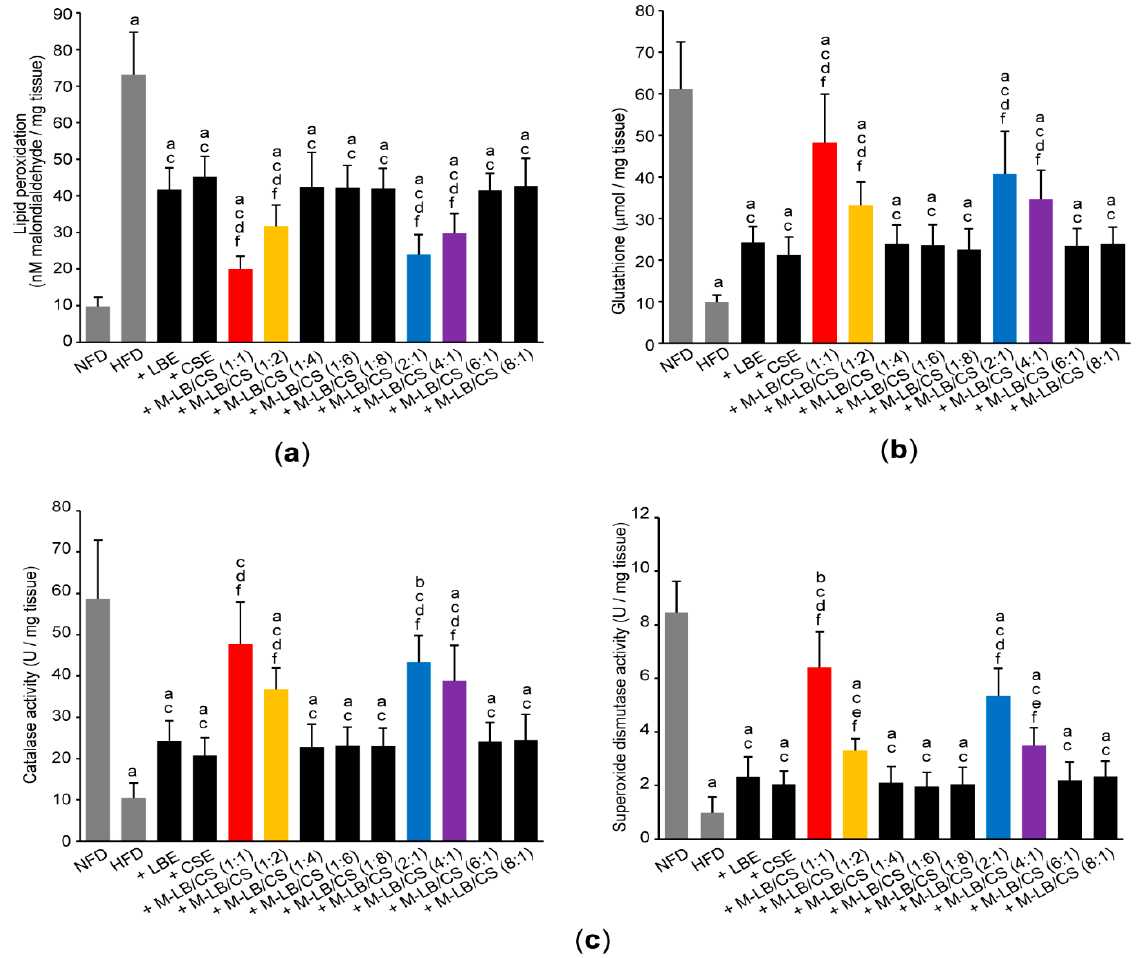
Figure 6. M-LB/CS scavenges lipid peroxidation. Malondialdehyde ( a ) and reduced glutathione ( b ) levels and specific activities of catalase and superoxide dismutase ( c ) were measured using liver homogenates. a p < 0.01, b p < 0.05, vs. NFD; c p < 0.01, vs. HFD; d p < 0.01, e p < 0.05, vs. HFD + LBE; f p < 0.01, vs. HFD + CSE.